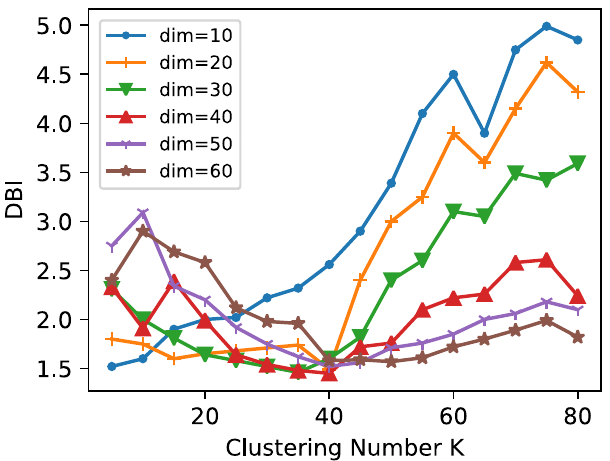
Figure 6. The obtained DBI under the different settings of cluster number K.